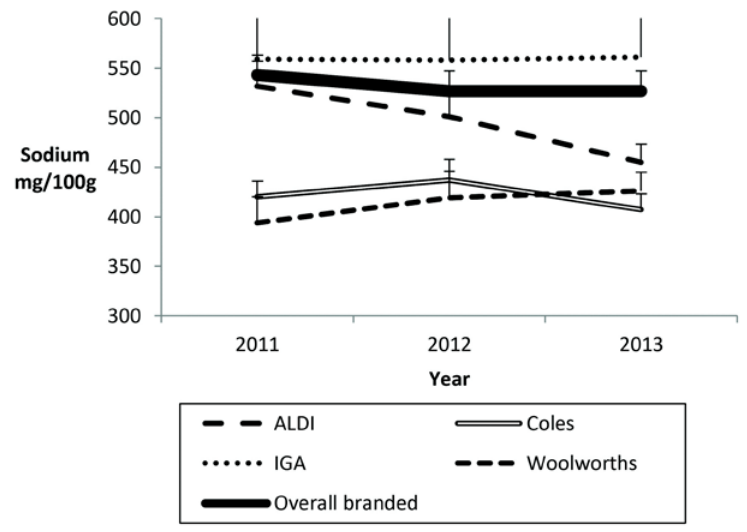
Figure 2. Mean sodium content (mg/100 g) and SE of supermarket private label products for supermarket retailers versus total branded (2011–2013).